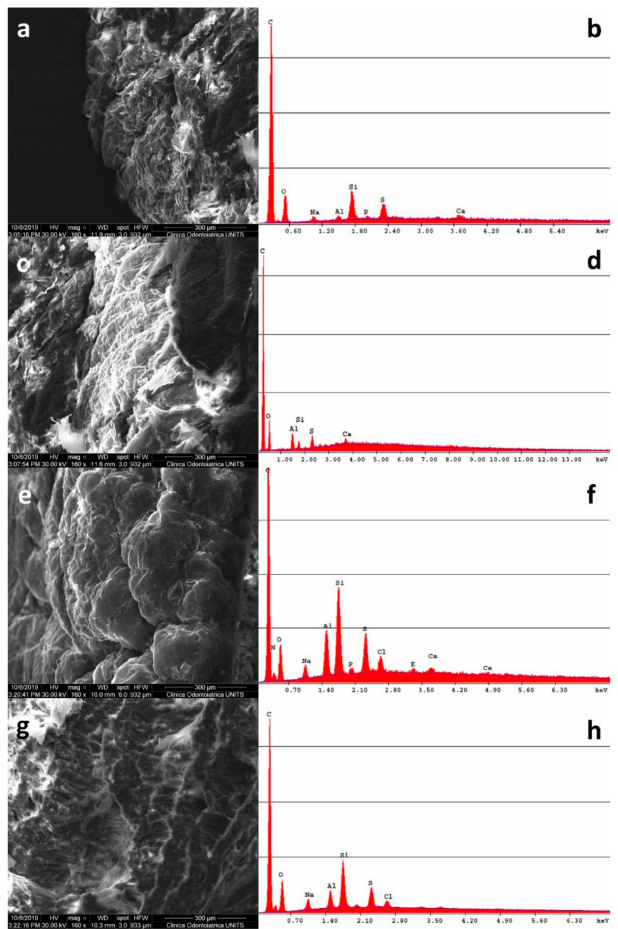
Figure 4. Representative SEM-EDS micrographs of skin samples treated with CeO 2 NPs and EDS spectra in full-frame acquisition mode: ( a ) epidermis of a blank cell and ( b ) relative EDS spectrum; ( c ) dermis of a blank cell and ( d ) relative EDS spectrum; ( e ) epidermis of an intact skin sample and ( f ) relative EDS spectrum; ( g ) dermis of an intact skin sample and ( h ) relative EDS spectrum. Bar = 300 µ m for ( a , c , e , g